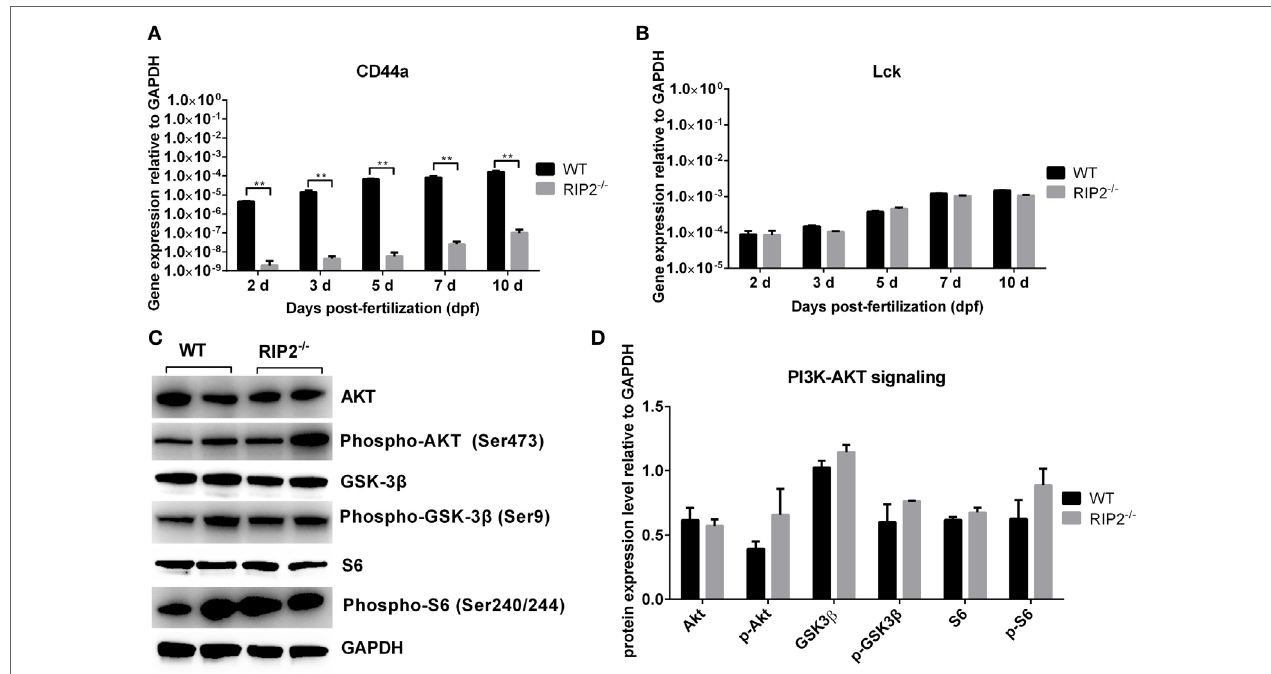
FigUre 7 | RIP2 is not essential for NOD1/CD44a-mediated activation of the PI3K-Akt signaling in the early ontogenesis. (a) The expression of CD44a in the WT and RIP2 − / − zebrafish. (B) The expression of Lck in the WT and RIP2 − / − zebrafish. For (a,B) , 30–50 embryos or larvae from WT and RIP2 − / − zebrafish were collected at 2, 3, 5, 7, and 10 days post-fertilization (dpf), and used for qPCR. Data represent the mean ± the SEM. ** p < 0.01. (c) Immunoblot analysis of Akt, phospho-Akt, GSK3 β , phospho-GSK3 β , S6, phospho-S6 in larvae homogenate from WT and RIP2 − / − zebrafish at 7 dpf. Western blotting results were quantified using Quantity One software. (D) Data represent the average of two independent experiments. * p < 0.05, ** p <